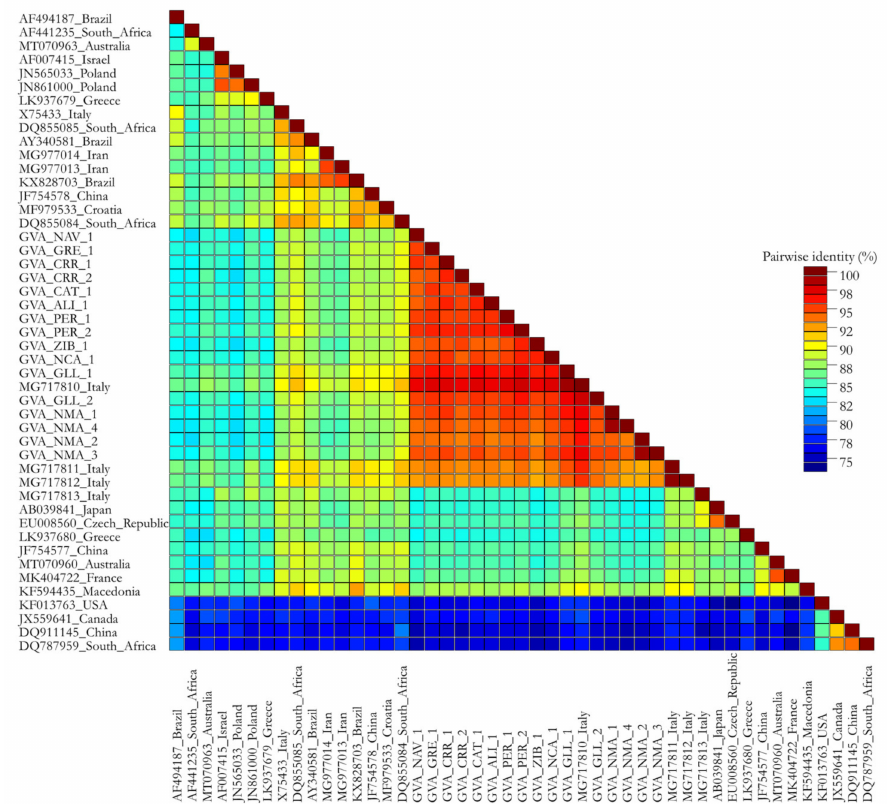
Figure 3. Graphical representations of pairwise percent identity of nucleotides of the sequenced CP gene between the GVA isolates from Sicily (Italy) and reference isolates using Sequence Demar- cation Tool v1.2 program. Each colored key represents a percentage of the identity score between two